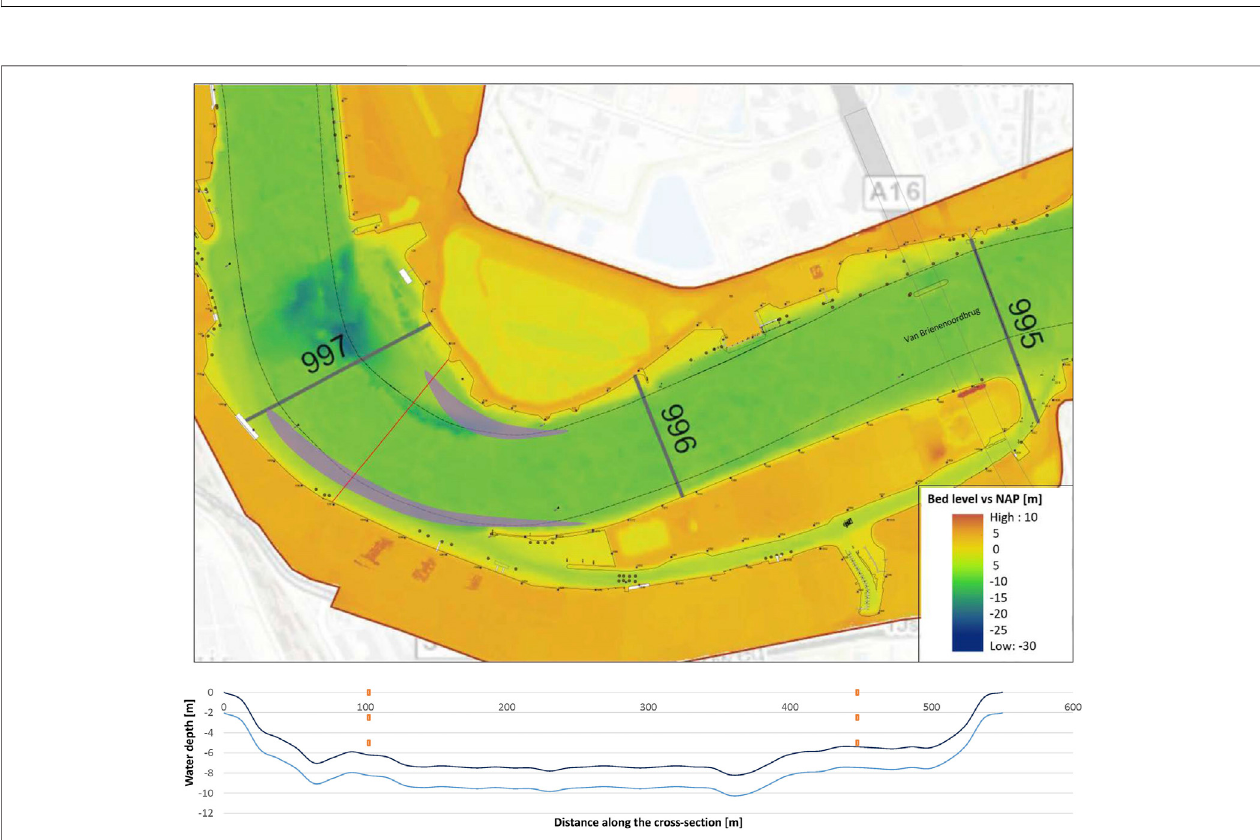
FIGURE 2 | [top] The bathymetry in the bend of the Nieuwe Maas (colors) with the shipping lanes (black dotted lines), three river kilometer lines and the areas in which static and dynamicsampling wascarried out inboth the inner and outer bend (grey shading) indicated; [bottom] a cross-sectionin the bend with the netlocations indicated at low tide (black) and at high tide (blue). Sources Rijkswaterstaat (monitoring data 2020) for bed level and Port of Rotterdam for navigation map.